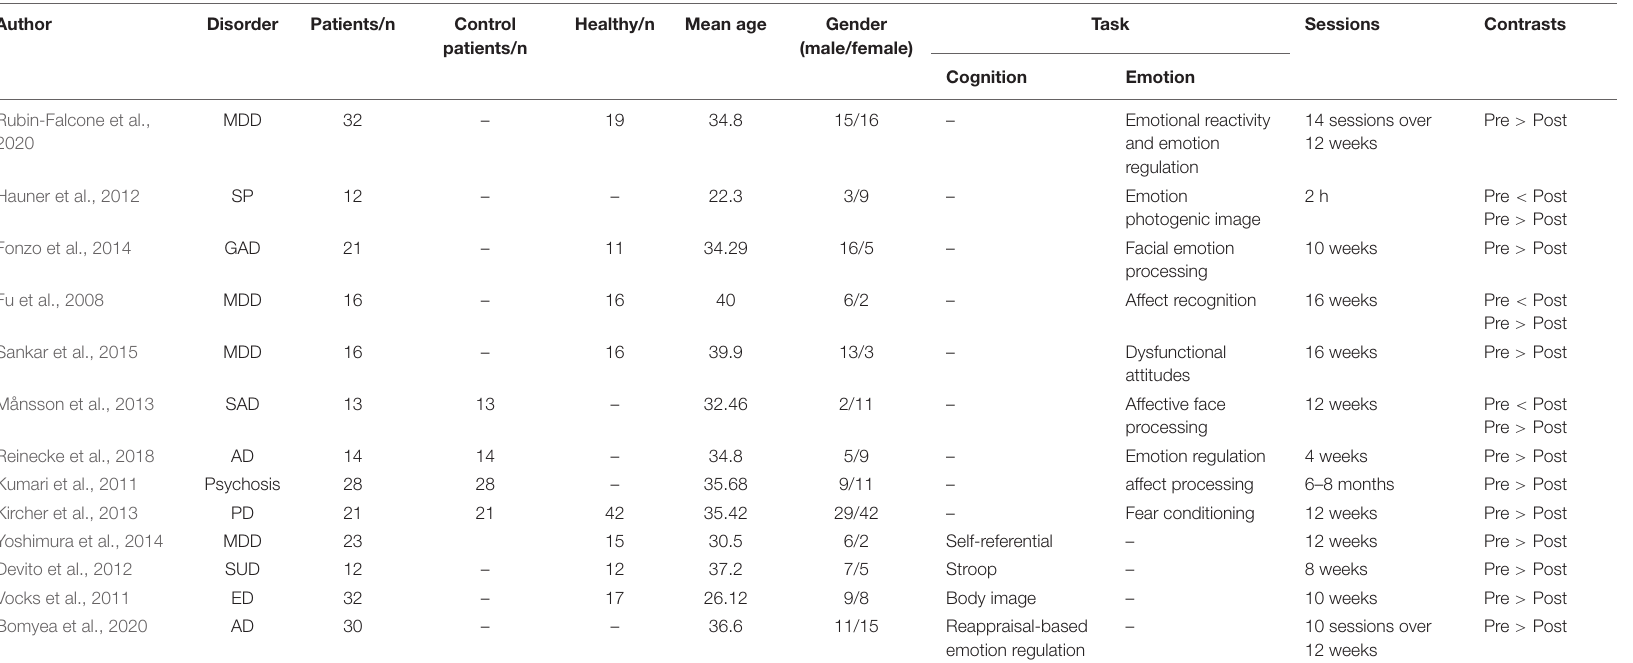
TABLE 1 | Characteristics of 13 included